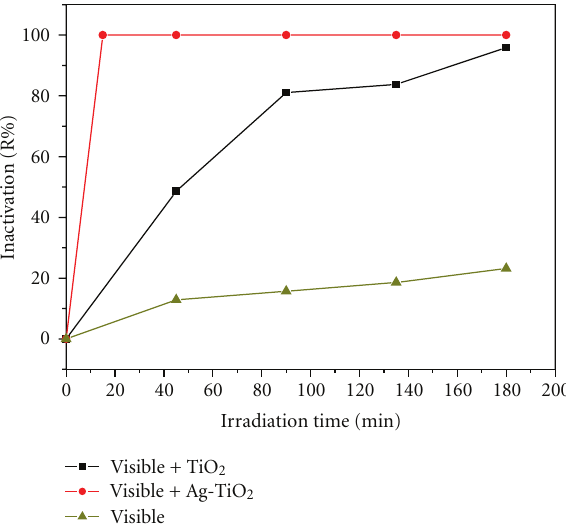
Figure 4: R percentage versus irradiation time of visible light (dosage = 0.01 g/10